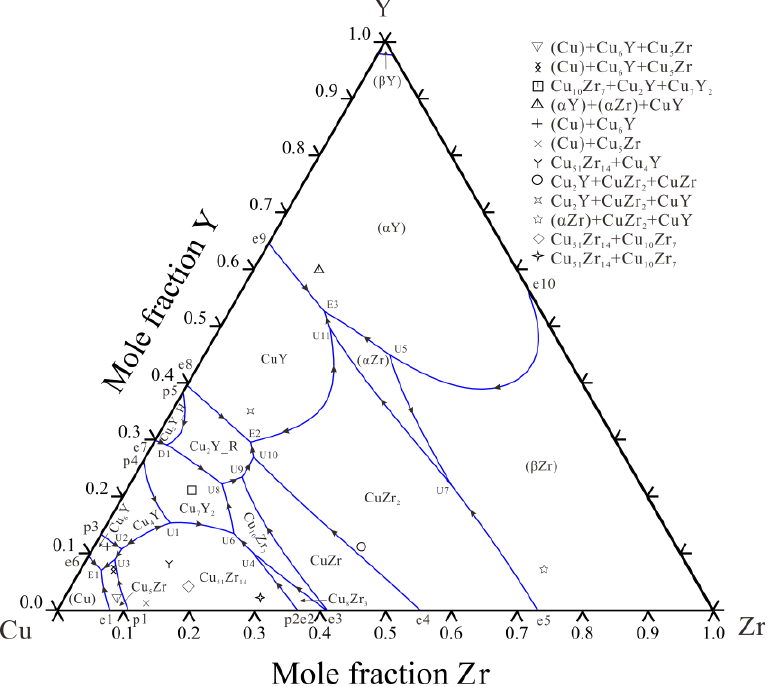
Figure 12. Calculated liquidus projection of the Cu – Zr – Y system with experimental data.